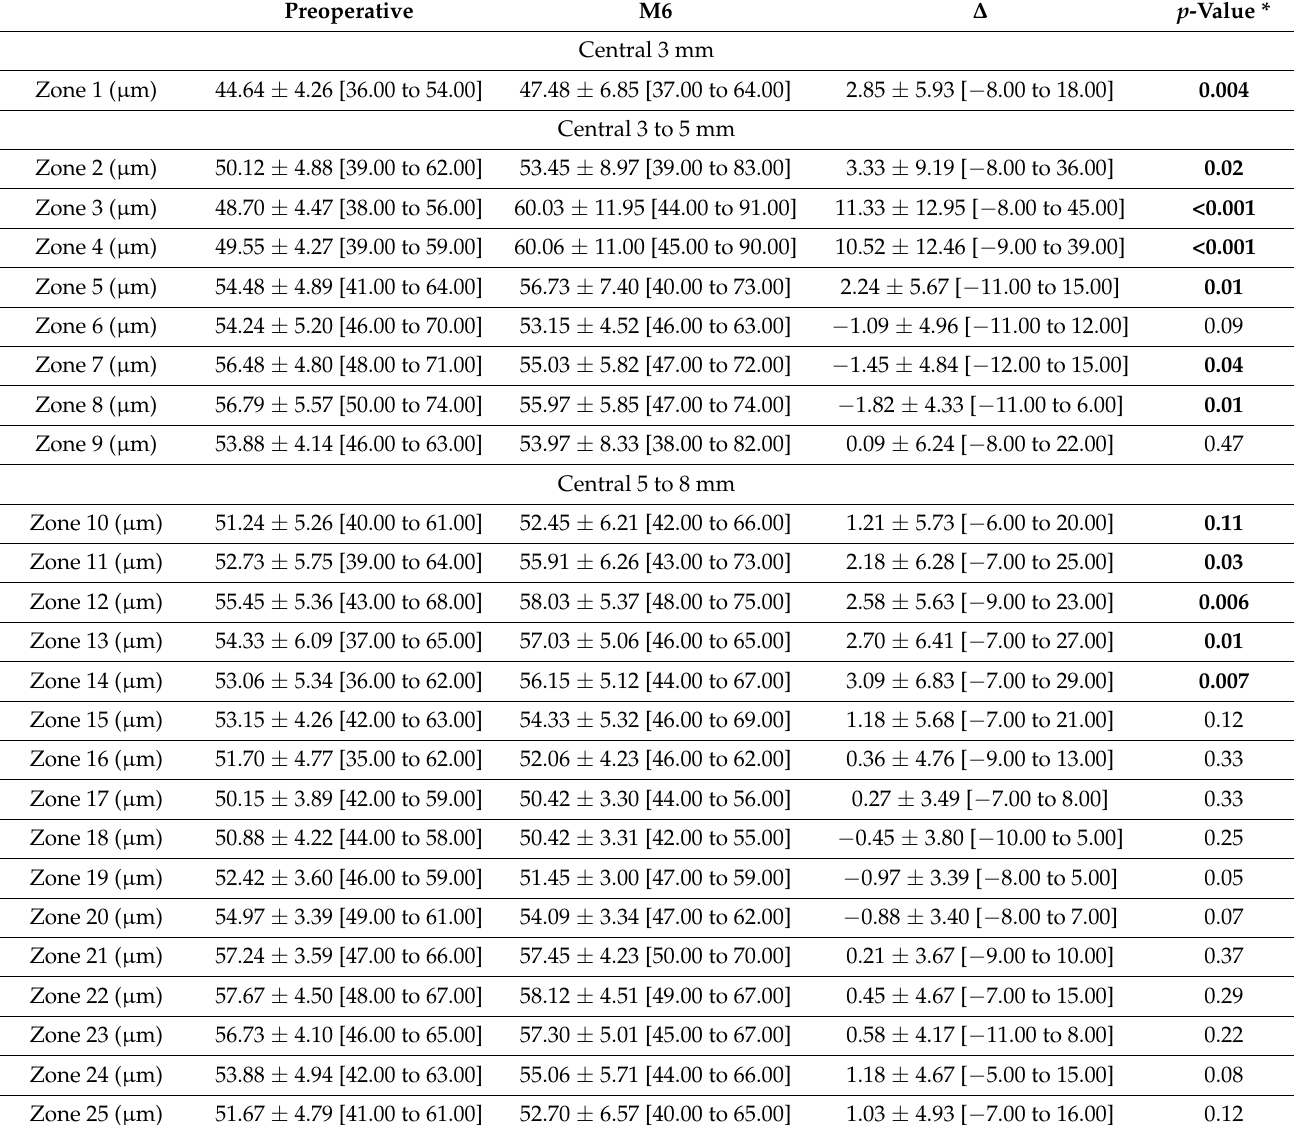
Table 5. Epithelial thickness in the central 8 mm ( n =